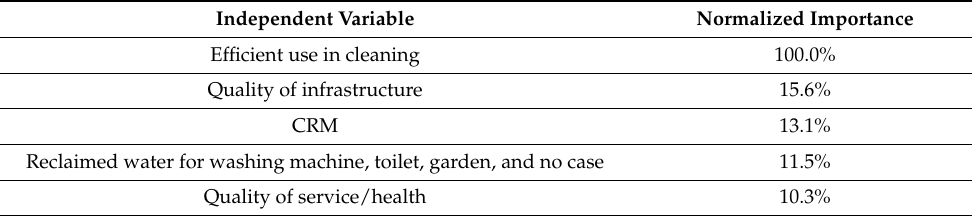
Table 1. Importance of the components of values/needs and attitudes together to predict the range of household consumption (Source: